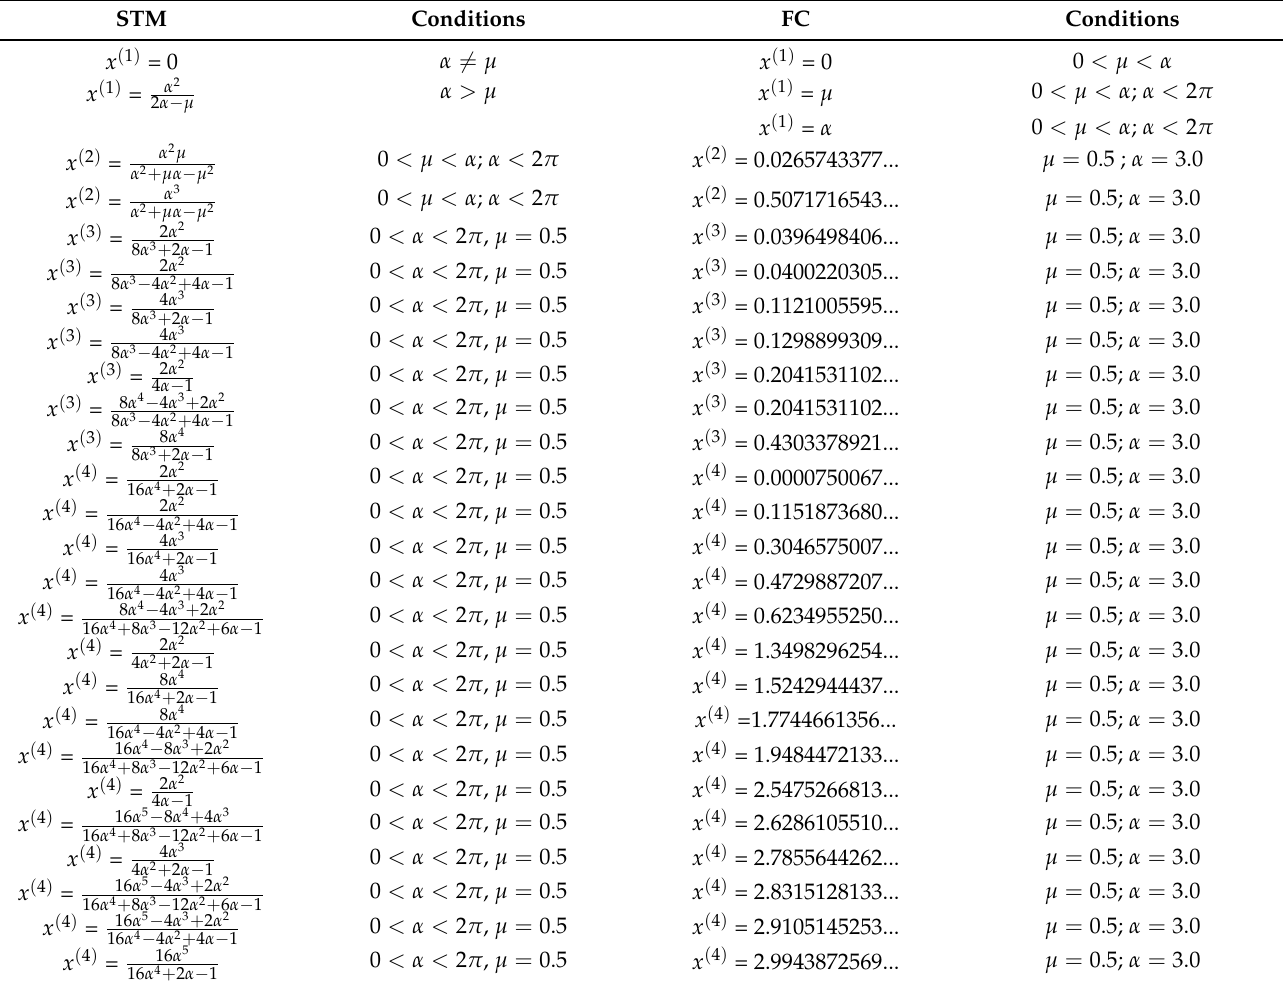
Table 1. Fixed points and conditions that produce periodic orbits for the two chaotic maps.